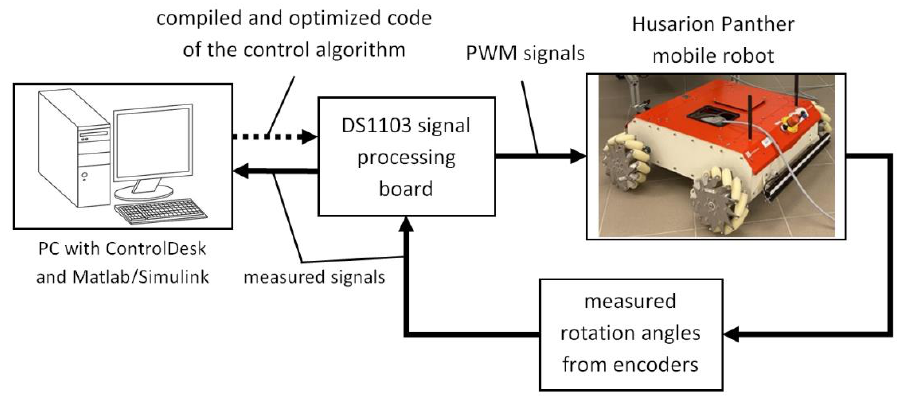
Figure 8. Diagram of the laboratory stand.